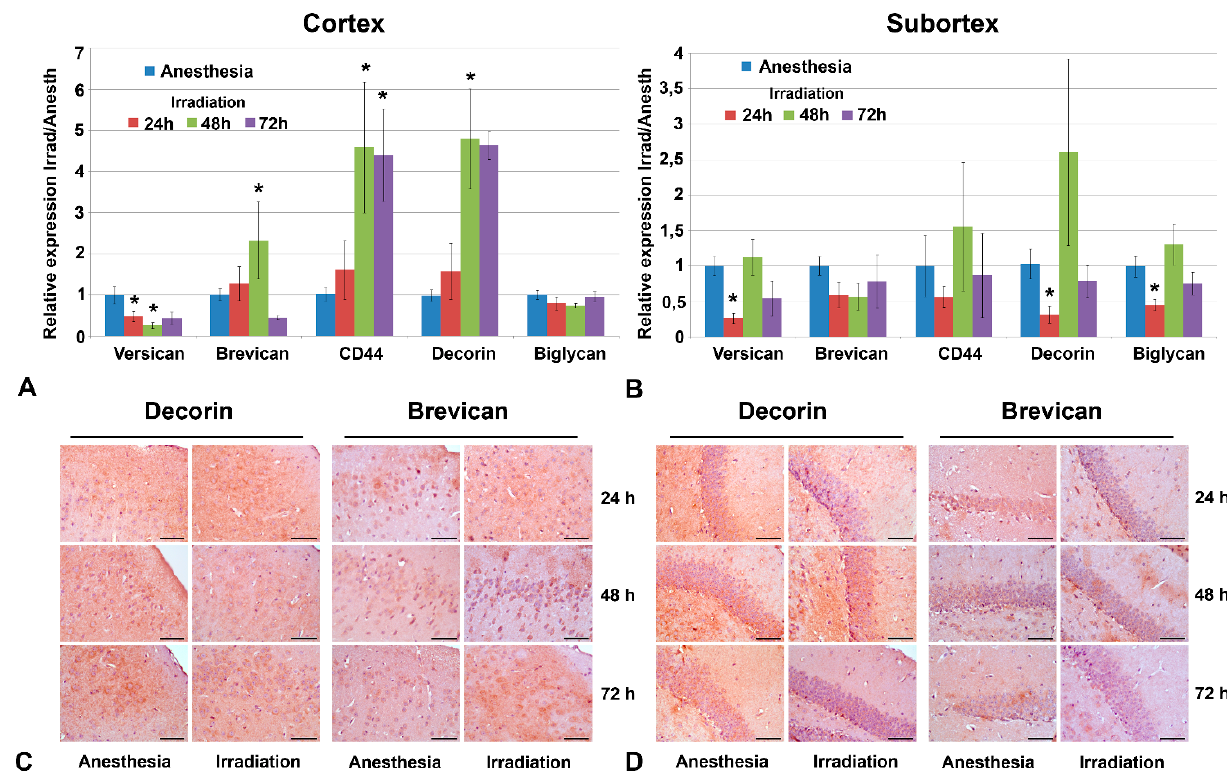
Figure 3. Expression levels of individual PGs in triple irradiated mouse brain tissue. ( A , B ) Real-time RT–PCR analysis, expression normalized to Gapdh , irradiated samples normalized to the appropriate control ones (anesthesia only). Bars represent the mean ± SD from triplicate experiments (OriginPro 8.5). ANOVA, a value of p < 0.05 was considered statistically significant (* p < 0.05). ( C , D ) Immunohistochemical staining for decorin and brevican core proteins. Magnification × 400, scale bar size 50 µm. PGs profiling and immunostaining were performed at 24, 48 and 72 h after irradiation.